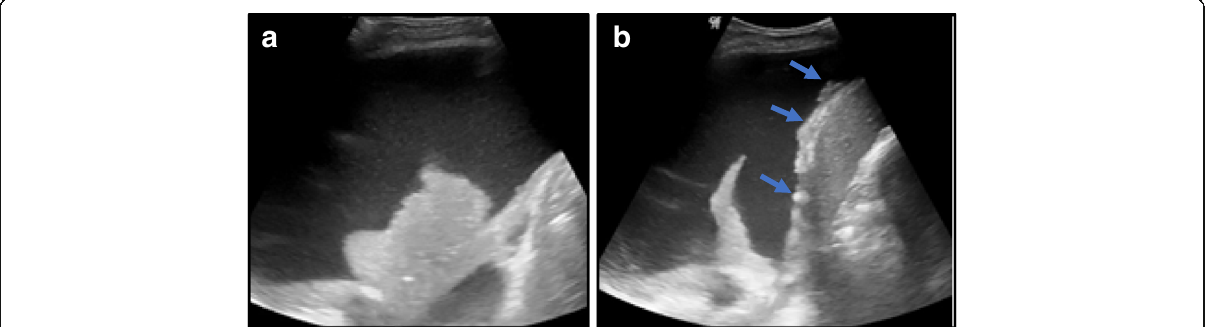
Fig. 2 US images show massive amount of free complex nonseptated pleural effusion with underlying collapsed lung ( a ). Note the pleural nodularity along the diaphragmatic pleura (blue arrow). Histopathology of the pleural nodules revealed necrotizing infiltrating